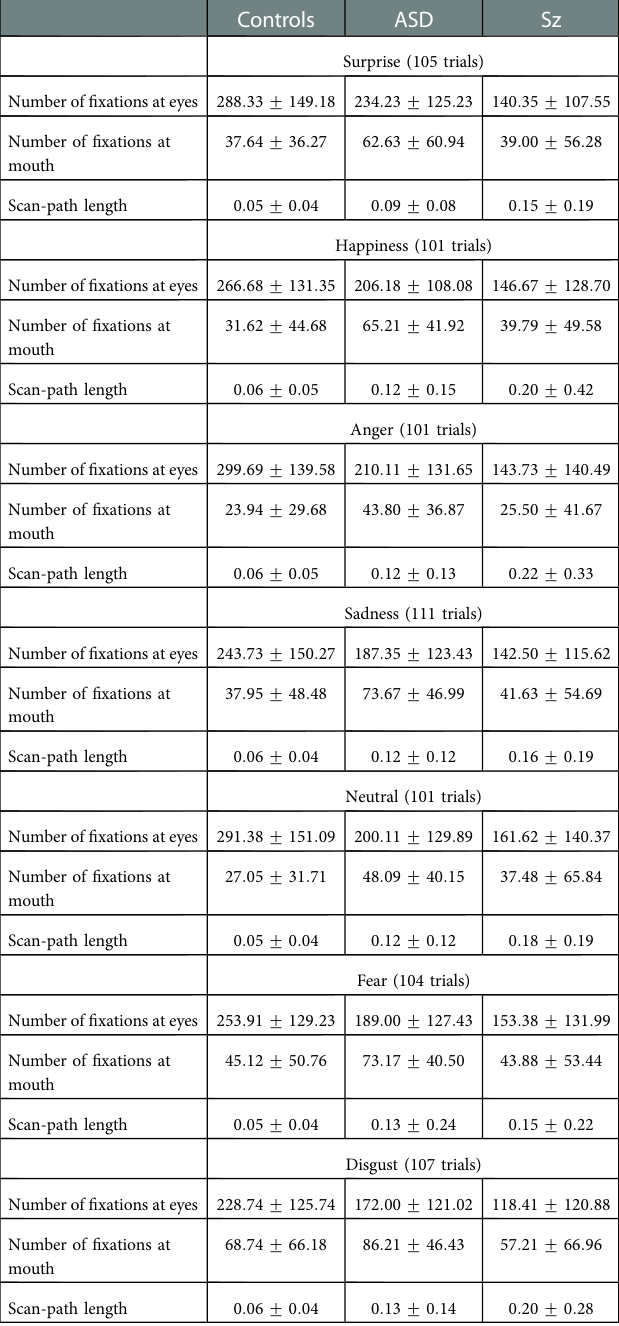
TABLE 3 Statistical analysis of control, ASD, and Sz adult participants ( mean + SD ) : Controls ASD Sz Surprise (105 trials)